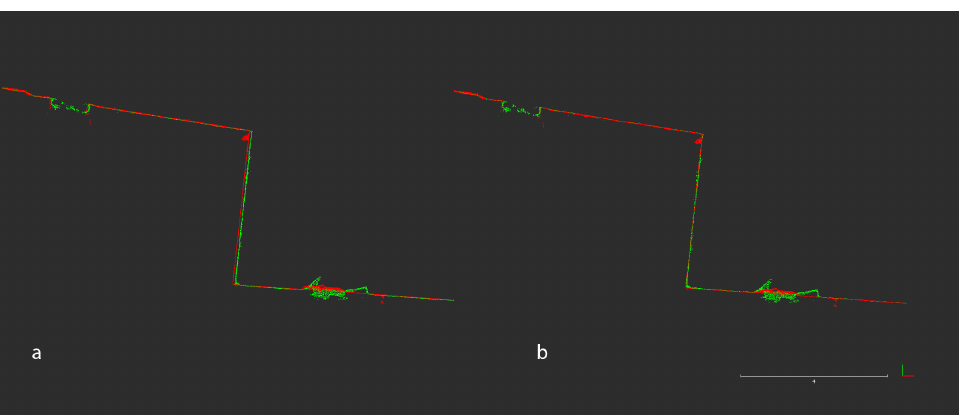
Figure 25. ICP alignment of Profile 3. Details of P1 (green) aligned with SX10 data (red): ( a ) before the alignment; ( b ) after the